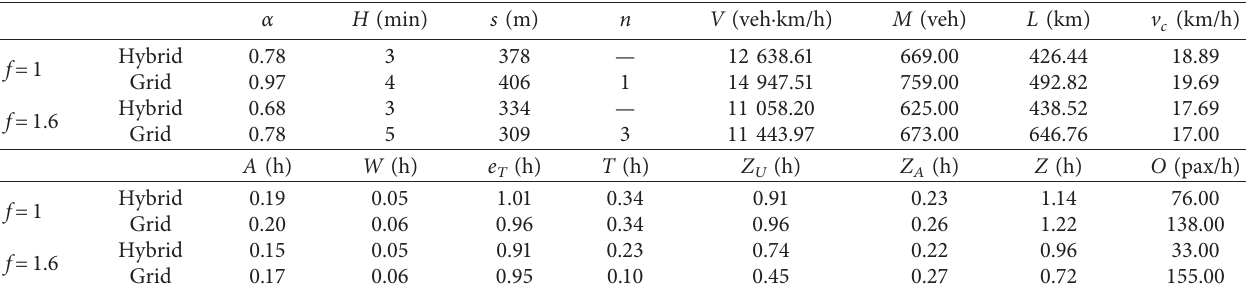
Table 3: Contrast of the sparse and dense mixed grid network and the grid-radial hybrid